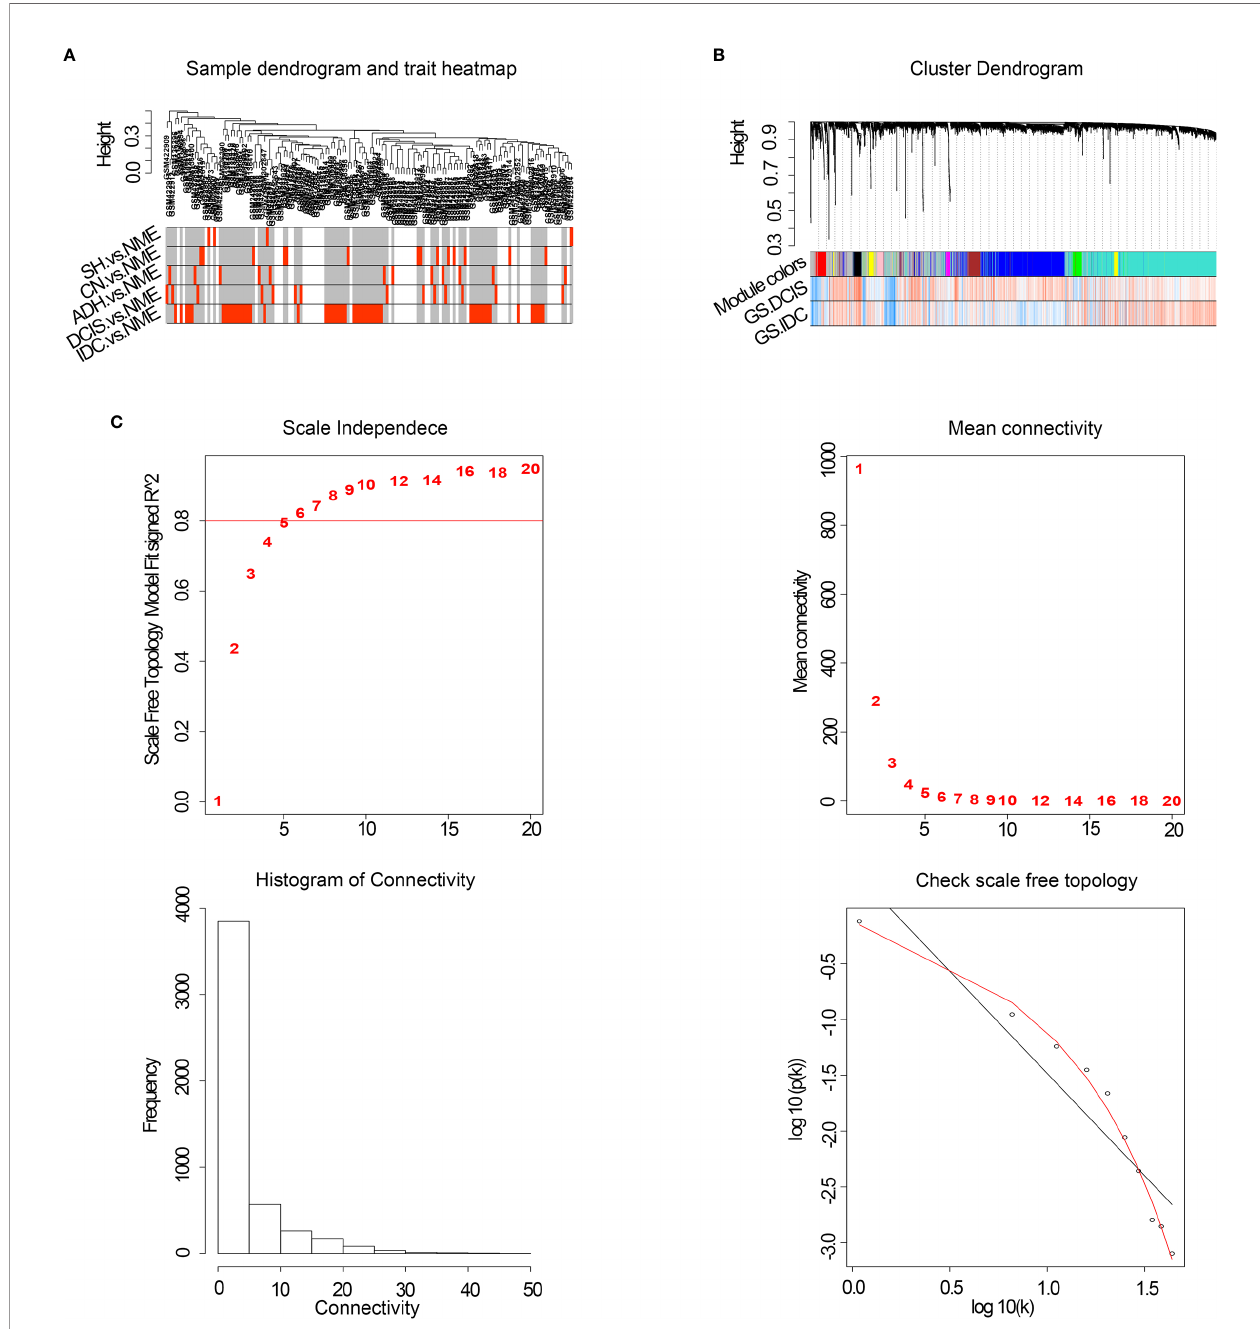
FIGURE 1 | (A) Cluster tree of breast cancer samples. (B) Analysis of network topology of various soft-thresholding powers. NME, normal mammary epithelium; SH, simple ductal hyperplasia; CN, cancer normal; ADH, atypical ductal hyperplasia; DCIS, ductal carcinoma in situ; IDC, invasive ductal carcinoma; GS, gene signi fi cance. (C) Hierarchical cluster analysis dendrogram. The gene clustering tree was obtained via hierarchical clustering of adjacency-based